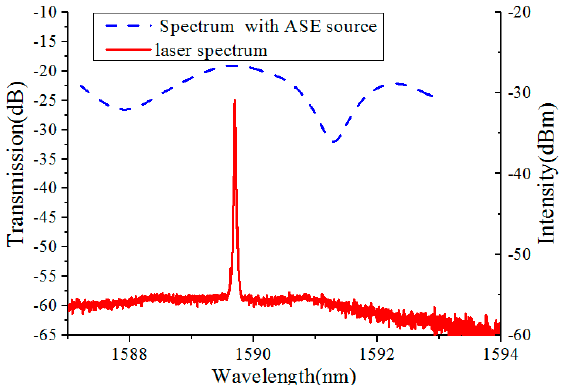
Figure 2. The comparison between the spectrum with amplified spontaneous emission (ASE) source (blue line) and laser spectrum (red line) after demodulated by the FRL.